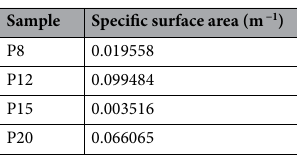
Table 2. Specific Surface Area of fiber on